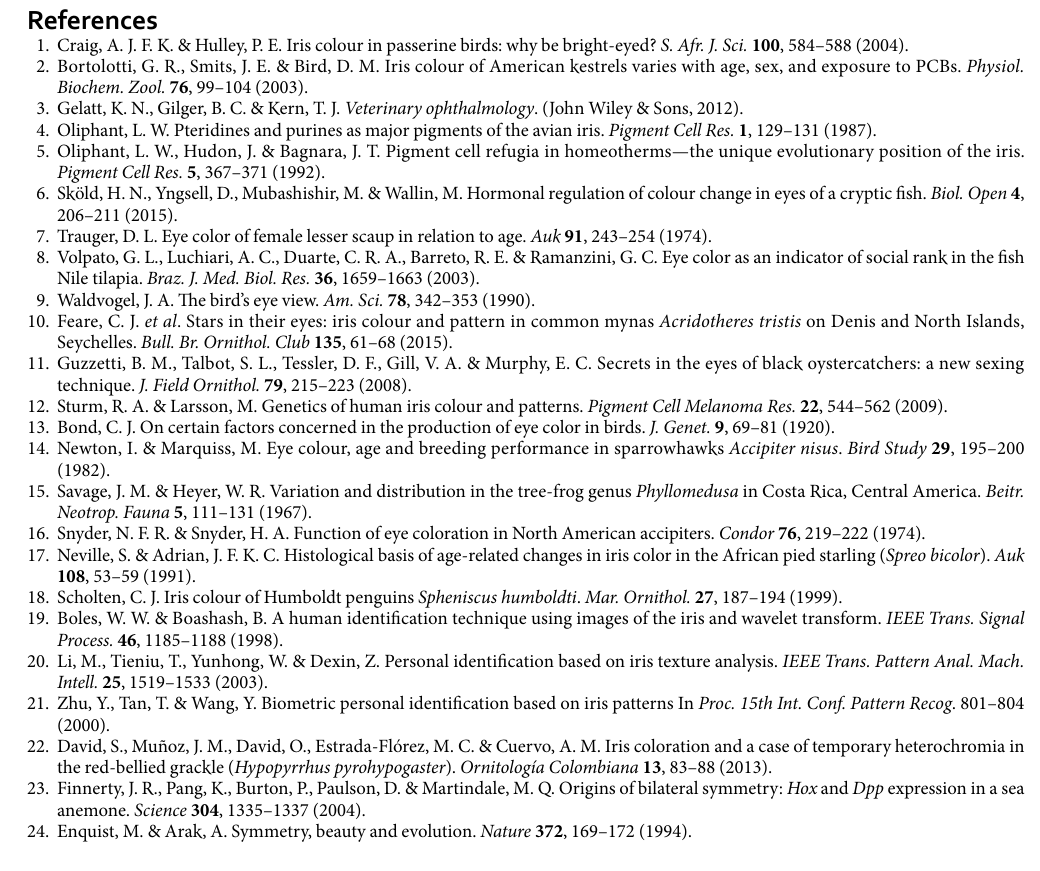
7 Scientific REPORtS | 7: 7612 | DOI:10.1038/s41598-017-08071-1